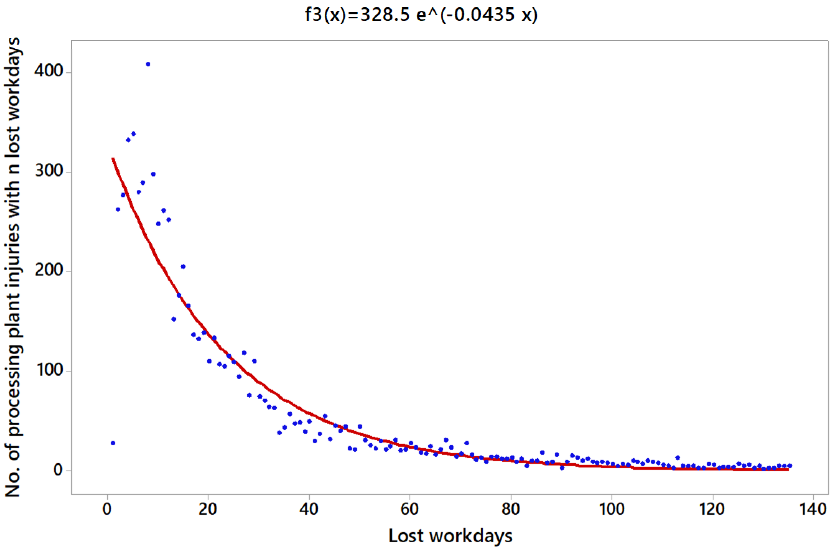
Figure 6. Regression model for the number of PP injuries.